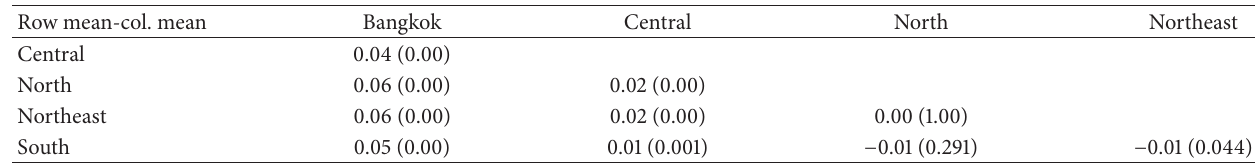
Table 6: Comparison of mean AAI of female older persons by region (Bonferroni test).